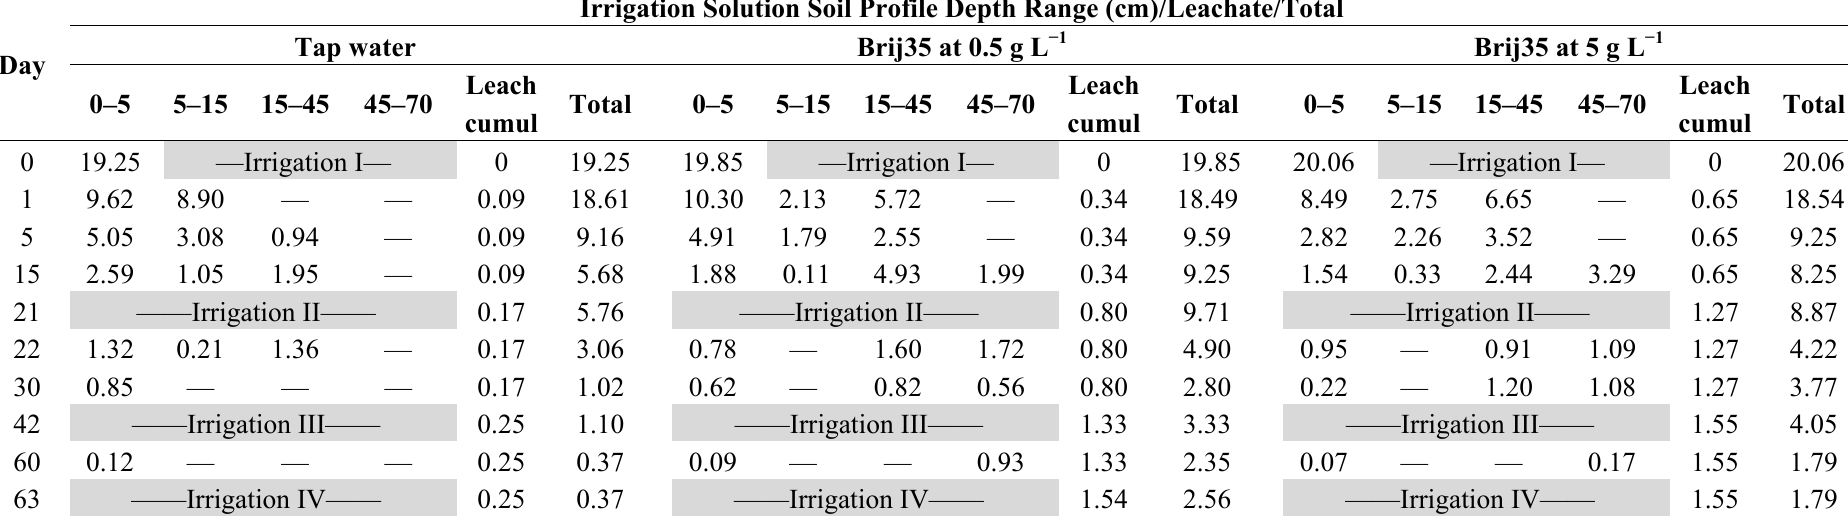
Table 3. Amounts of metribuzin (mg) in different soil profile depth ranges, cumulated in leachate, and overall, over a 63 day period. Soil samplings on days 0, 1, 15, 22, 30, and 60 at depths of 2, 10, 30 and 60 cm depths, as well as and irrigations followed by leachate sampling on Days 1, 21, 42, 63. (—, metribuzin was below detection